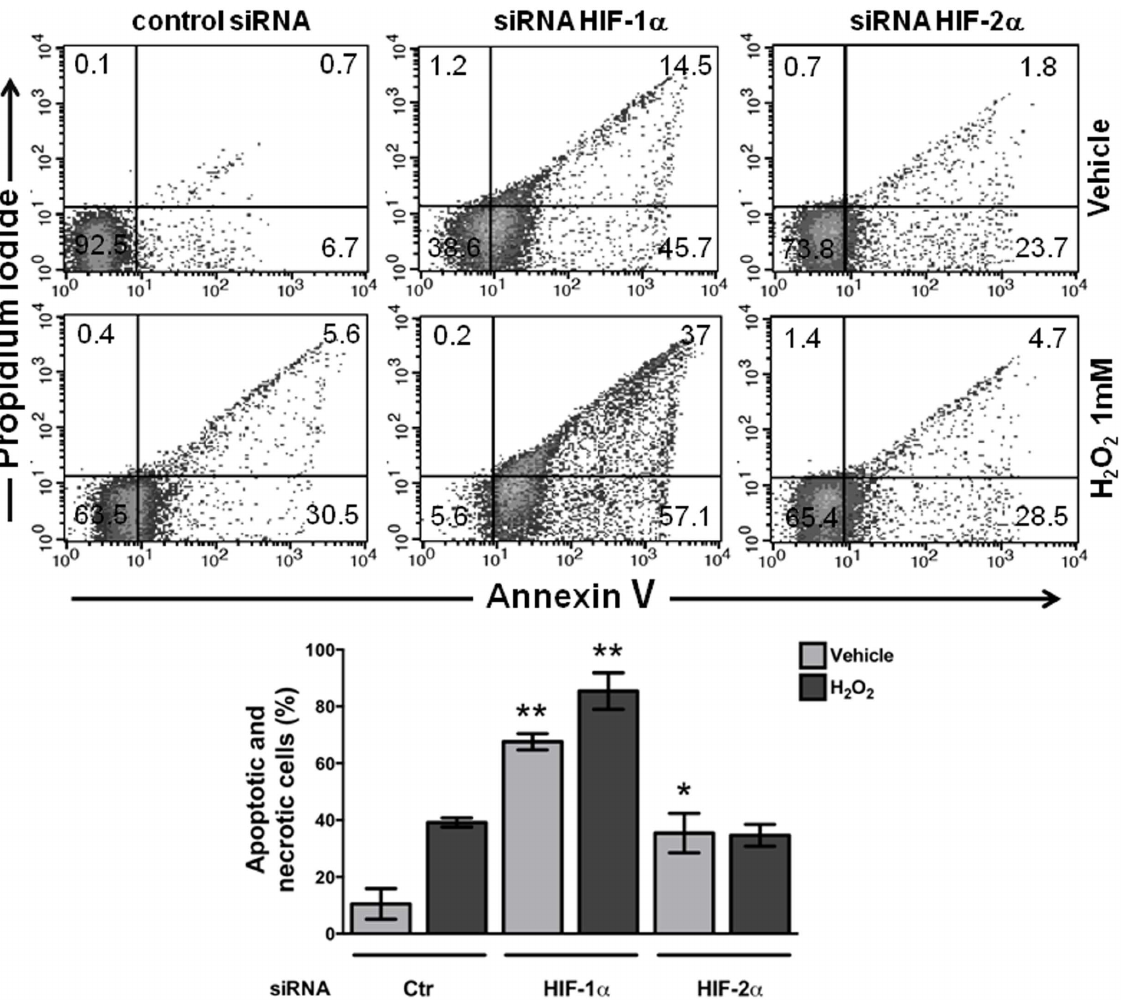
Figure 3. HIF knockdown increased the apoptosis of SW480 cells. Apoptosis was induced by culturing the HIF-silenced or control (transfected with scrambled shRNA plasmid and indicated in the figure as Ctr) cells in the absence or presence of 1 mM H 2 O 2 for 12 h. SW480 cells were trypsinized, washed twice with PBS, and untreated (vehicle) or treated with H 2 O 2 for 12 h. The cultures were stained with Annexin V and PI, as described in the ‘‘Materials and Methods’’, and analyzed by flow cytometry. All of the assays were performed in triplicate (a representative histogram of the data is shown), and the graph presents the means 6 SEM from three independent experiments; *: p , 0.05; **: p , 0.01.